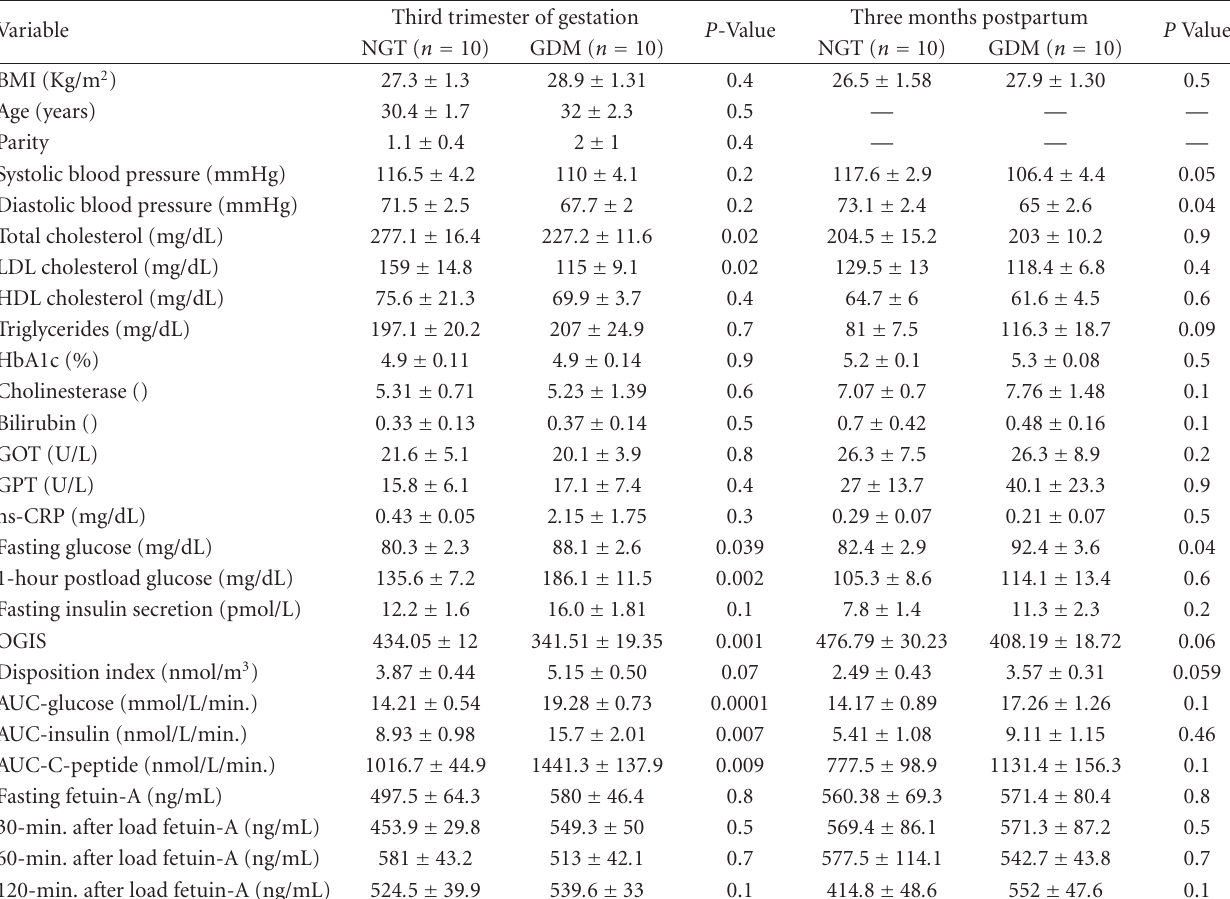
Figure 1: (a) Boxplot of OGIS level (mL min − 1 m − 2 ) in women with and without gestational diabetes mellitus during pregnancy ( P = 0 . 001). (b) Boxplot of OGIS level (mL min − 1 m − 2 ) in women with and without gestational diabetes mellitus 3 months after delivery ( P = 0 . 06). Table 1: Patient’s characteristics and laboratory